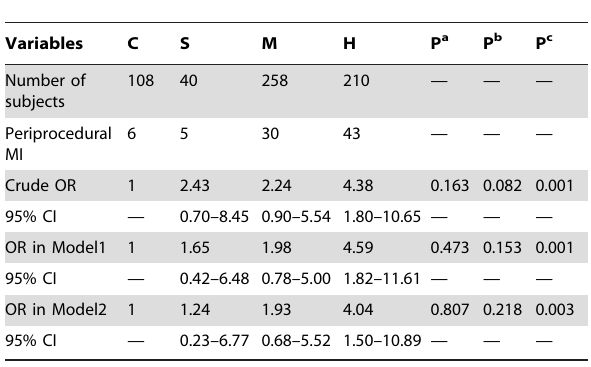
CI indicates confidence interval. Other abbreviations were as followed in Table 2.